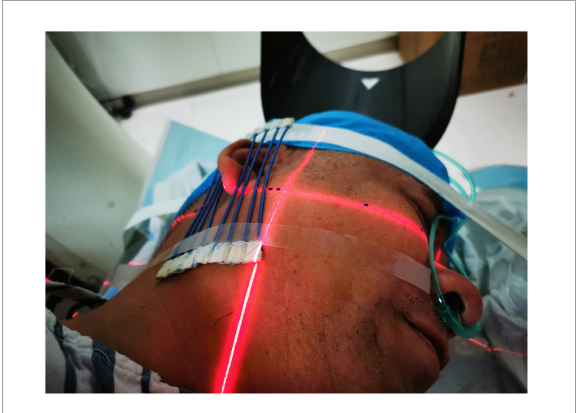
FIGURE1 Placement of the CT positioning grids. CT positioning grids were placed anterior and posterior to the patient’s ear.